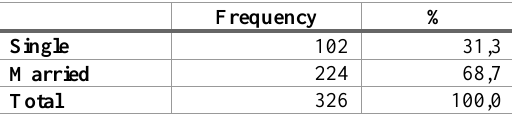
Table 11: Findings on Marital